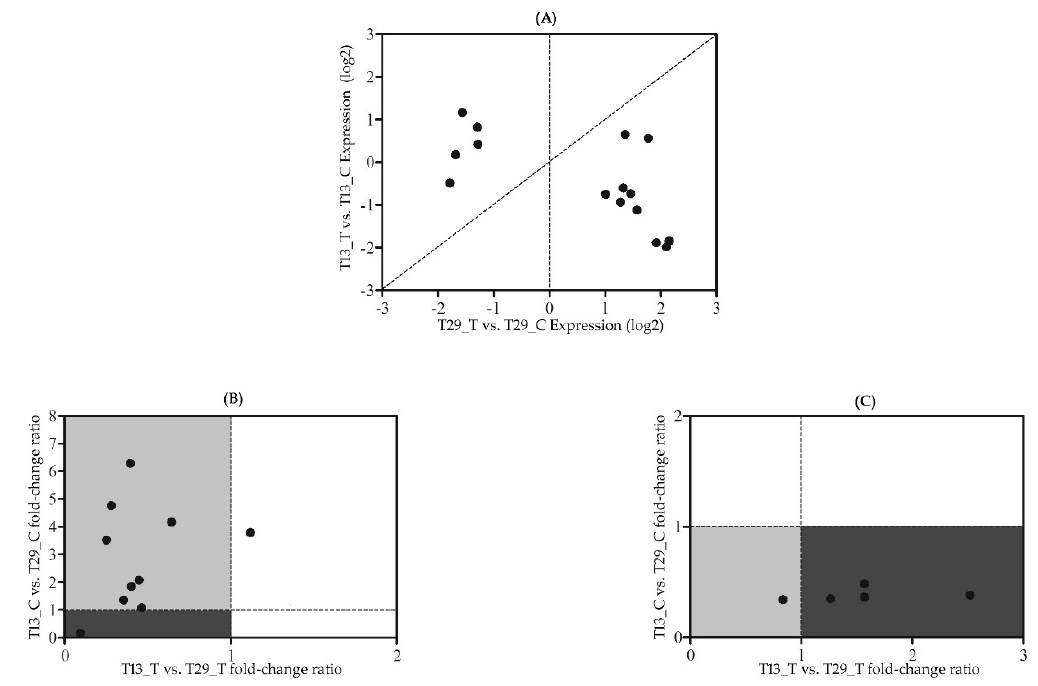
Figure 6. Scatter plot of expression between low-NUE T13 and high-NUE T29 across the 15 differently expressed genes unique to T29_T vs. T29_C. ( A ) Scatter plot of the log2 fold-changes in expression of 15 genes that were unique to T29_T vs. T29_C in response to N-deficit stress in T29 and T13. ( B ) Comparison of the relative ratio of treatment-to-control fold-changes in expression of the 10 upregulated DEGs unique to T29_T vs. T29_C between T29 and T13. ( C ) Comparison of the relative ratio of treatment-to-control fold-changes in expression of the five downregulated DEGs unique to T29_T vs. T29_C between T29 and T13. Each filled dot represents an individual gene; the dotted-line is a 1:1 line; the gray and dark portions of the ( B ) graph represent the frontloaded and stress-tolerance genes, respectively; the gray and dark portions of the ( C ) graph represent stress-tolerance or relatively upregulated genes, respectively.